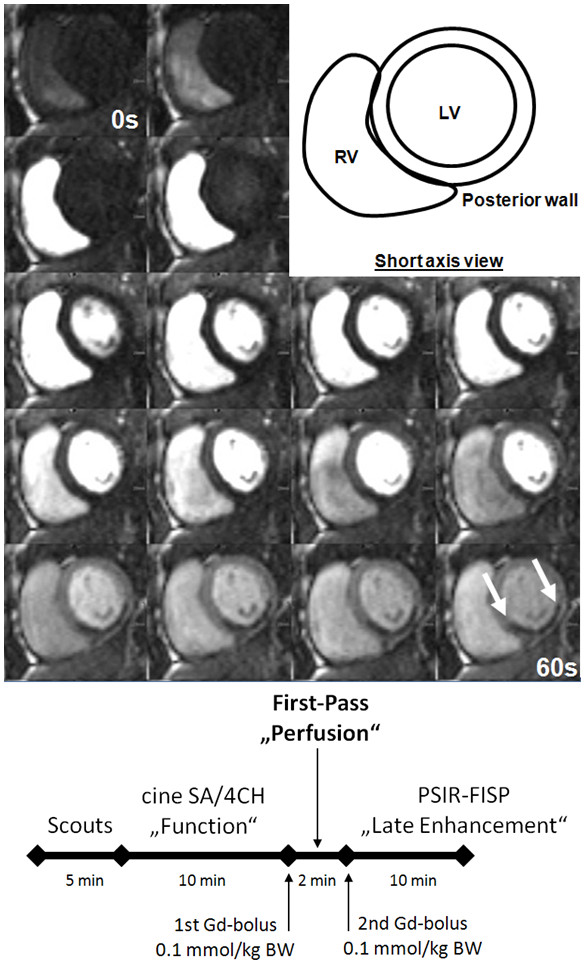
Consecutive slices acquired during first gd-pass (a). The flow-chart below (b) shows the timeline of one CMR. RV: right ventricle, LV: left ventricle, SA: short axis, 4CH: four chamber, Gd: gadolinium, BW: bodyweight, PSIR-FISP: phase-sensitive inversion-recovery fast-imaging-in-steady-state-precession.